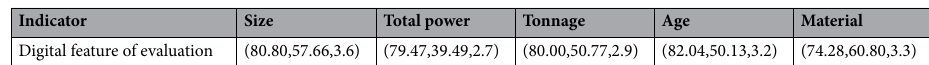
Table 14. Fishing vessels specification index expert evaluation cloud model.